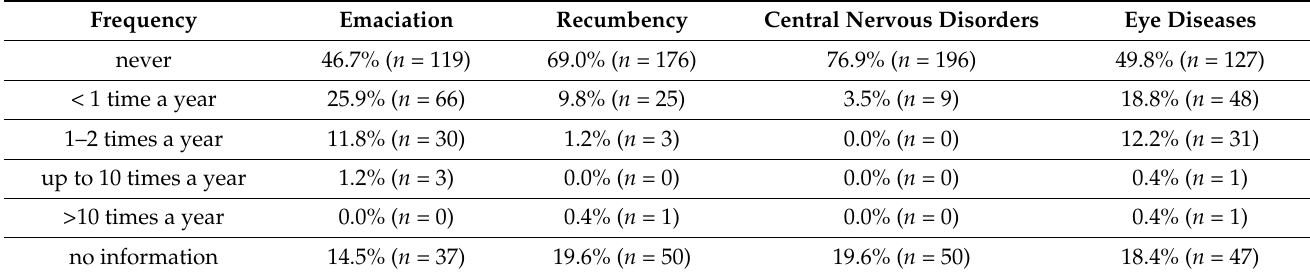
Table 11. Observation of the owners: frequency of other diseases or symptoms ( n =